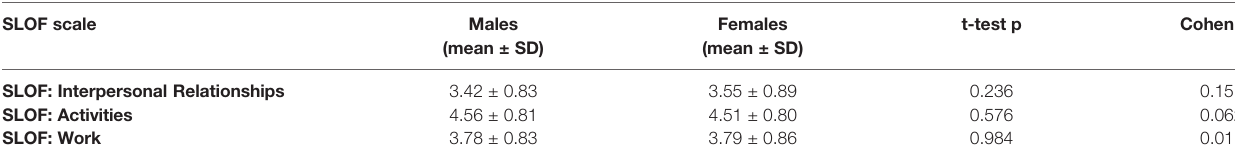
TABLE 6 | Functional outcome differences between male and female patients (t-test) in patients with Low PANSS-G16 (3 or lower). SLOF